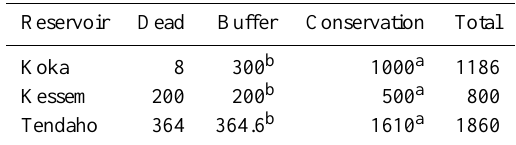
Table 1. Management zones and total storage in 10 6 m 3 , ( a ) denotes upper constraints and ( b ) denotes lower